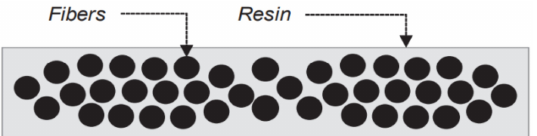
Figure 1. Prepreg [25]. Reprinted with permission from